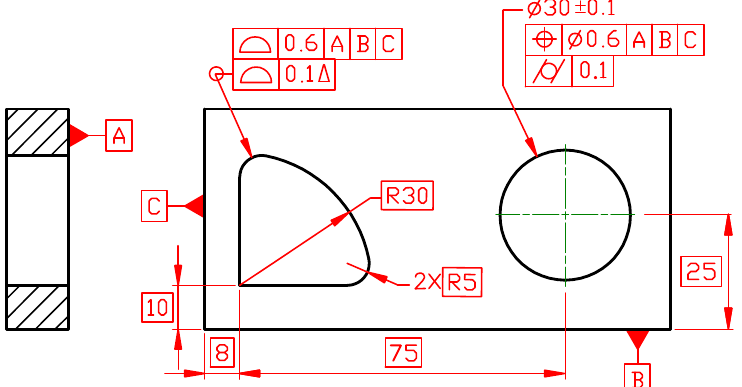
Figure 21. The dynamic surface profile tolerance for the left hole with a complex shape controls its form in similar way as cylindricity tolerance controls the form for the right cylindrical hole (ASME Y14.5).